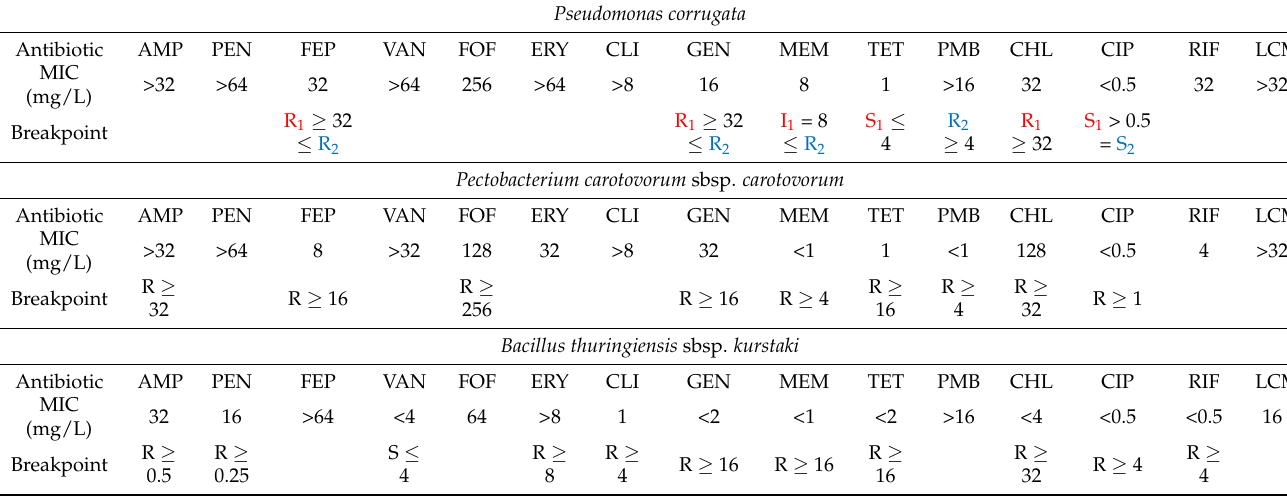
Table 1. Susceptibility testing of the plant-pathogenic bacterium Pseudomonas corrugata . Methods were used as previously described [134,135]. Interpretive criteria (S: susceptible, I: intermediate, and R: resistant) are based on the Clinical